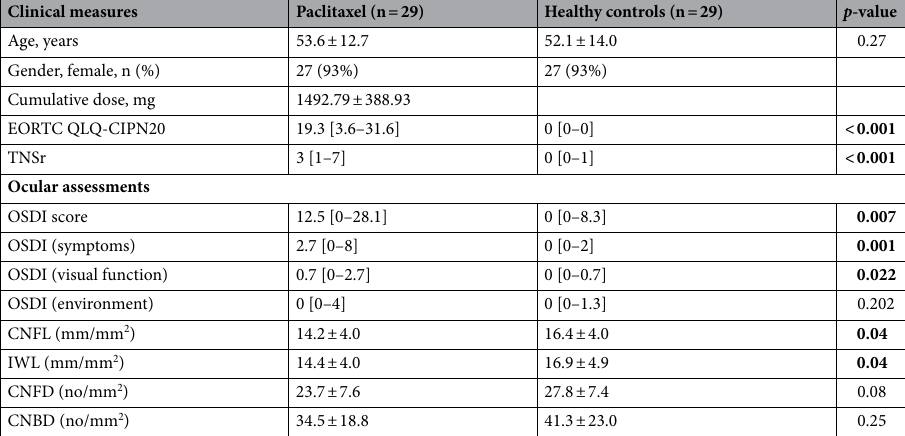
Table 2. Clinical characteristics and assessment results of study participants. EORTC QLQ-CIPN20, The European Organization for Research and Treatment of Cancer Quality of Life Questionnaire in Chemotherapy-induced Peripheral Neuropathy Questionnaire scale; TNSr, reduced Total Neuropathy Scale; OSDI, Ocular Surface Disease Index; CNFL, corneal nerve fiber length; IWL, inferior whorl length; CNFD, corneal nerve fiber density; CNBD, corneal nerve branch density. Data is reported as mean ± standard deviation, or median with interquartile range [Quartile 1–Quartile 2]. The Mann Whitney U test was used to compare the data of the matched groups. Significant results are presented in bold.